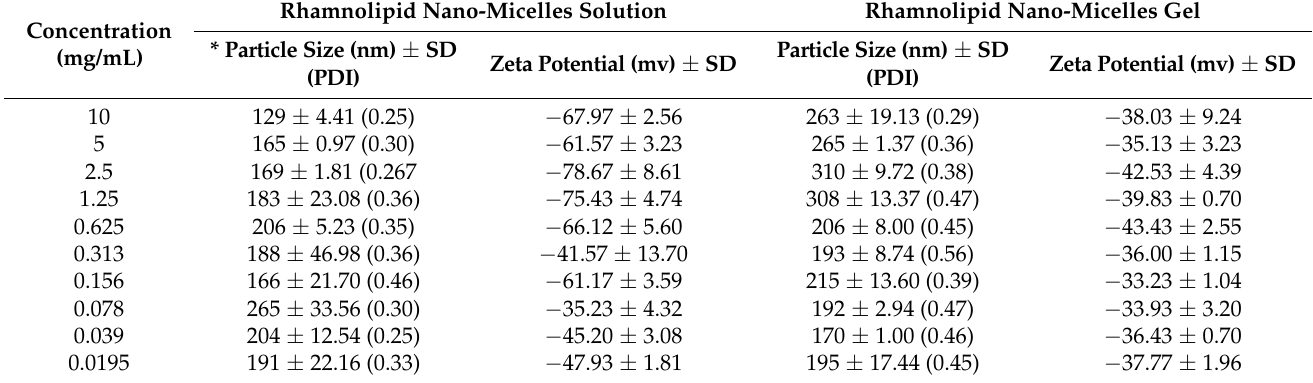
Table 1. Characterization of rhamnolipid nano-micelles hand sanitizers after serial dilution with PBS. Rhamnolipid Nano-Micelles Solution Rhamnolipid Nano-Micelles Concentration (mg/mL)